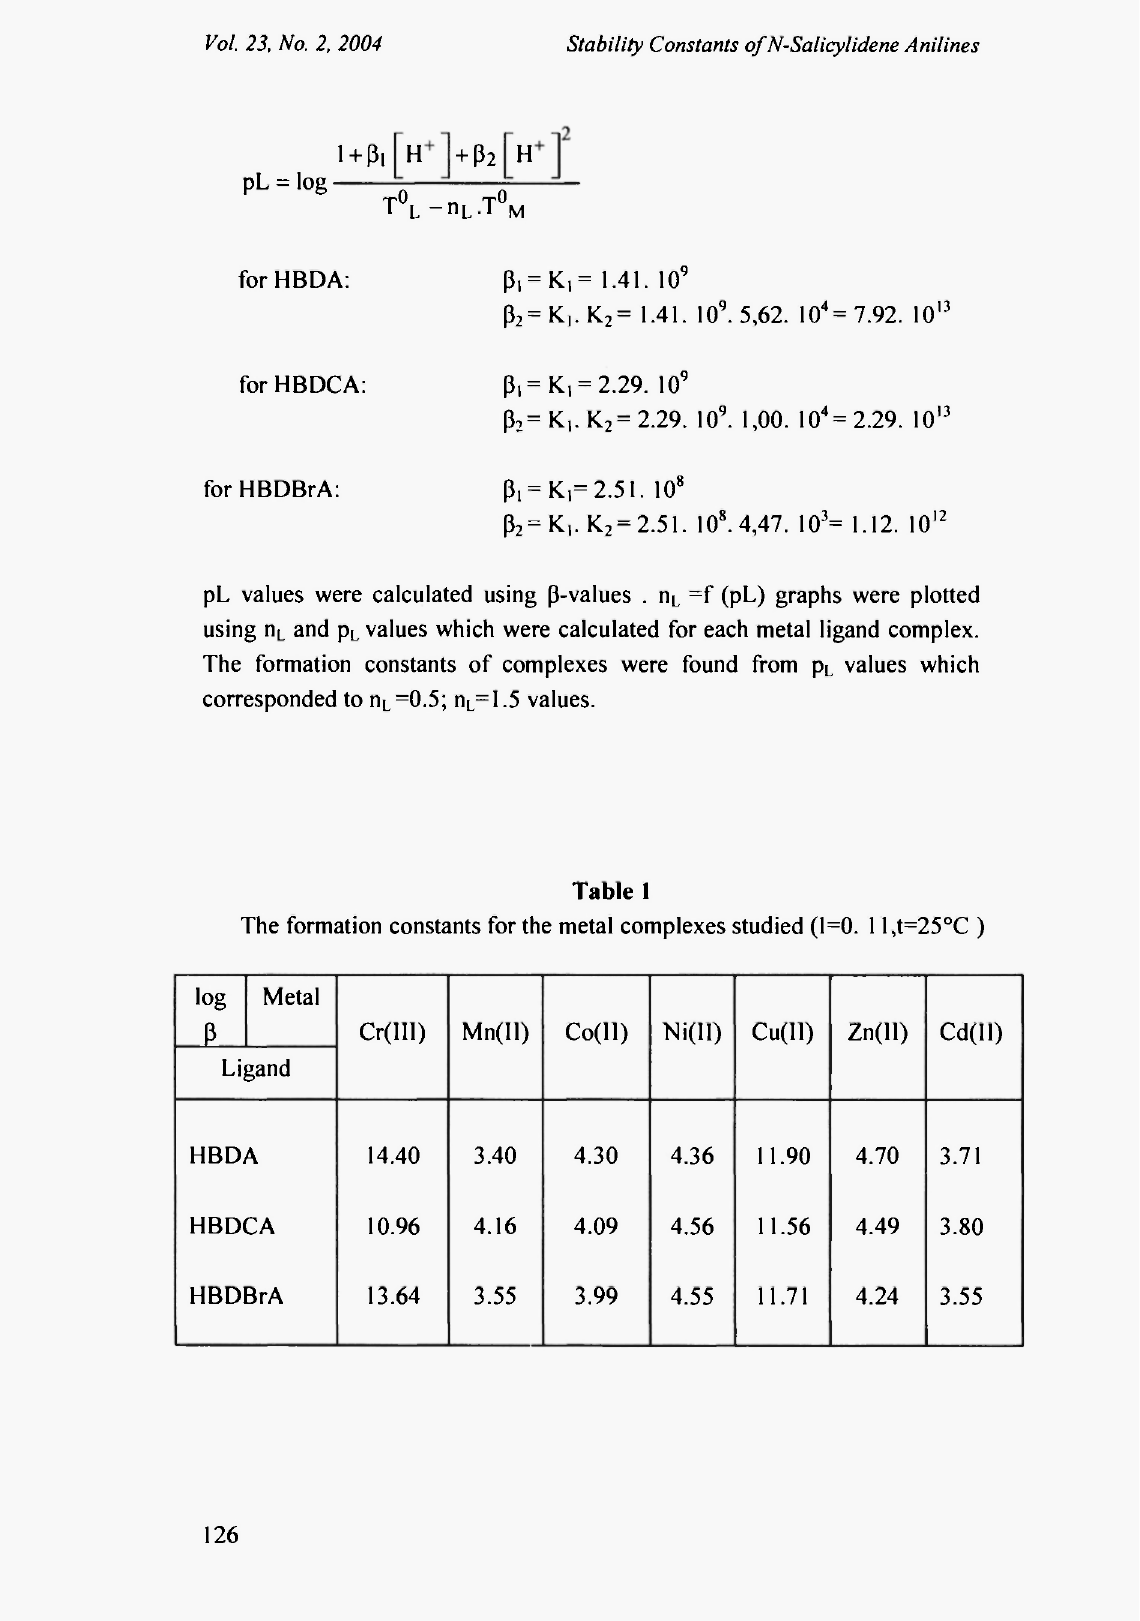
The formation constants for the metal complexes studied (1=0. 11 ,t=25°C